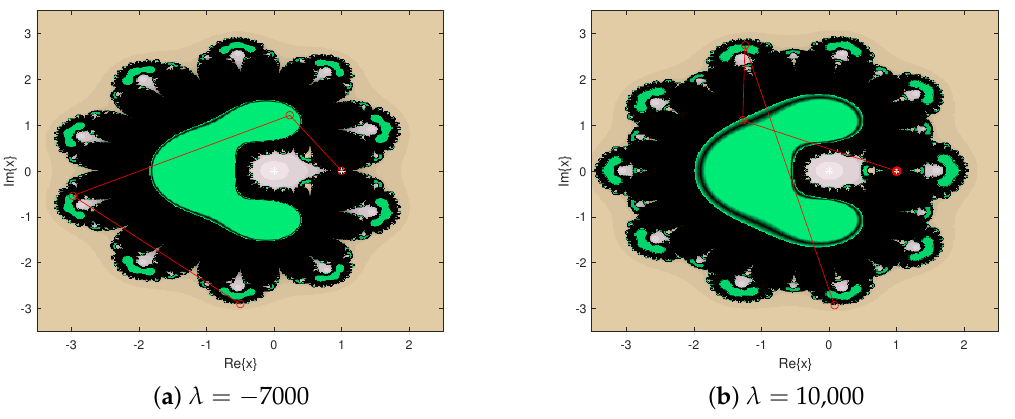
Figure 6. Dynamical planes for special λ -values.